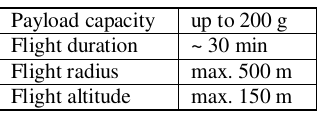
Table 1. Some technical specifications of MD4-200